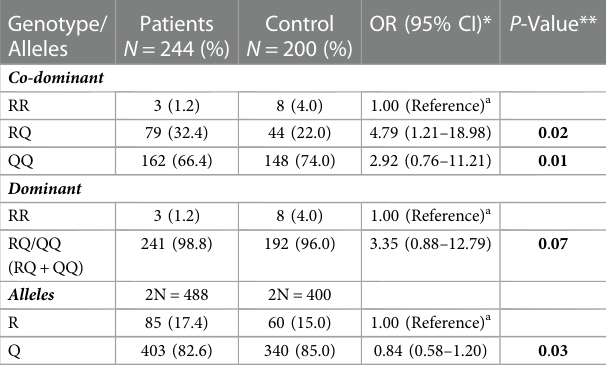
show a signi fi cant association with T1DM. N , the number of subjects in which genotypes were identi fi ed in each